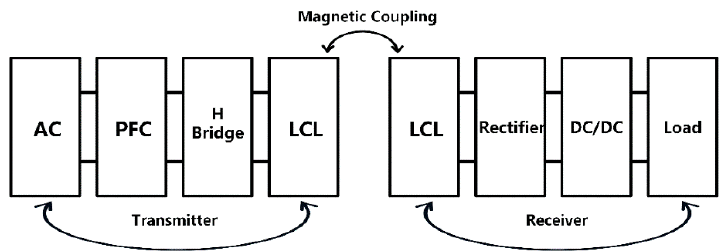
Figure 7. Schematic of wireless charging system, AC represents the 220 V alternating